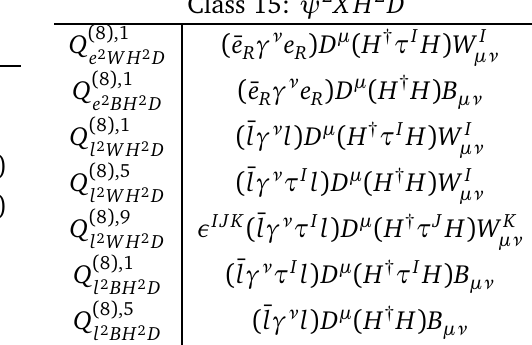
Table 2: Novel operator forms occuring first at dimension-eight which contribute to H → ¯ (cid:96)(cid:96)γ . The parenthesis in D ( µ D ν ) indicate symmetrization in the Lorentz indices. l is the left handed lepton SU ( 2 ) singlet. Operators such as ( ¯ l γ ν l )( H †